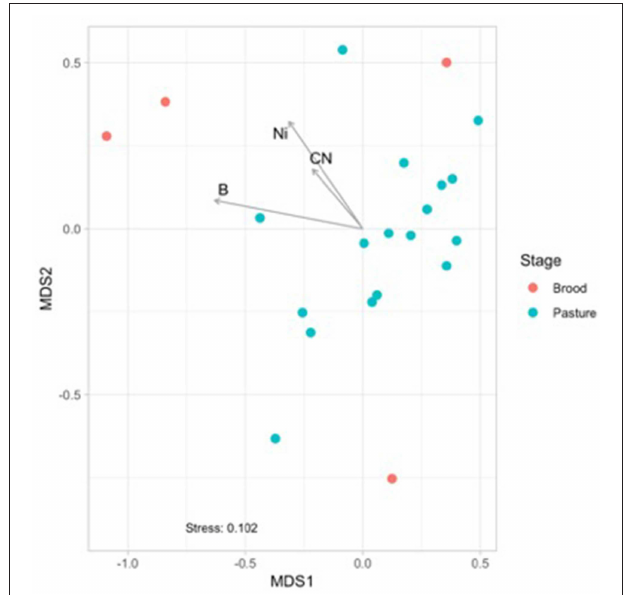
FIGURE 3 | Non-metric multidimensional scaling (NMDS) based on Bray Curtis dissimilarities of broiler fecal microbiomes from the brood and pasture stages. The broiler age (in weeks) is overlaid on the different points within the graph, with 1A − 3 representing brood fecal microbiomes and 4A − 16 representing pasture fecal microbiomes. Significant physiochemical parameters (B, C:N ratio, Ni; p < 0.01) were fitted onto the NMDS plot using the envfit function in the VEGAN